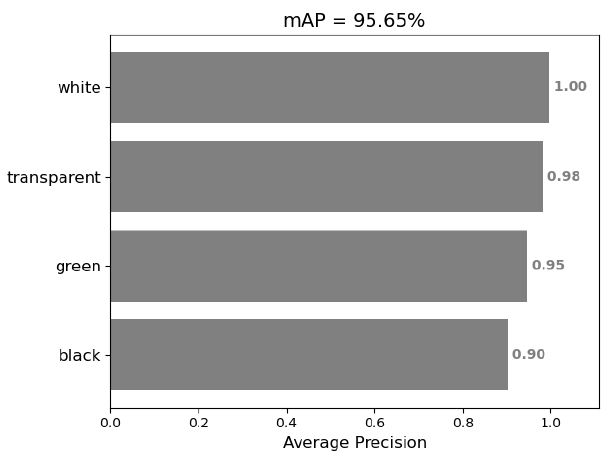
Figure 12. mAP of YOLOv3 detection result.